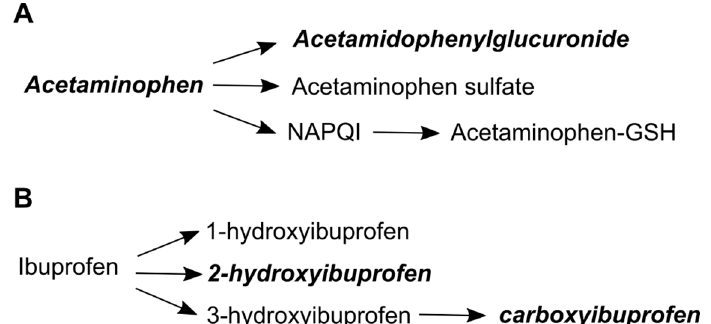
Figure 3. Acetaminophen and ibuprofen metabolism. Initial metabolism steps for acetaminophen ( A ), and ibuprofen ( B ). Bolded metabolites were used as indicators to assess use. Abbreviations: NAPQI is N-acetyl-p-benzoquinone and GSH is glutathione.